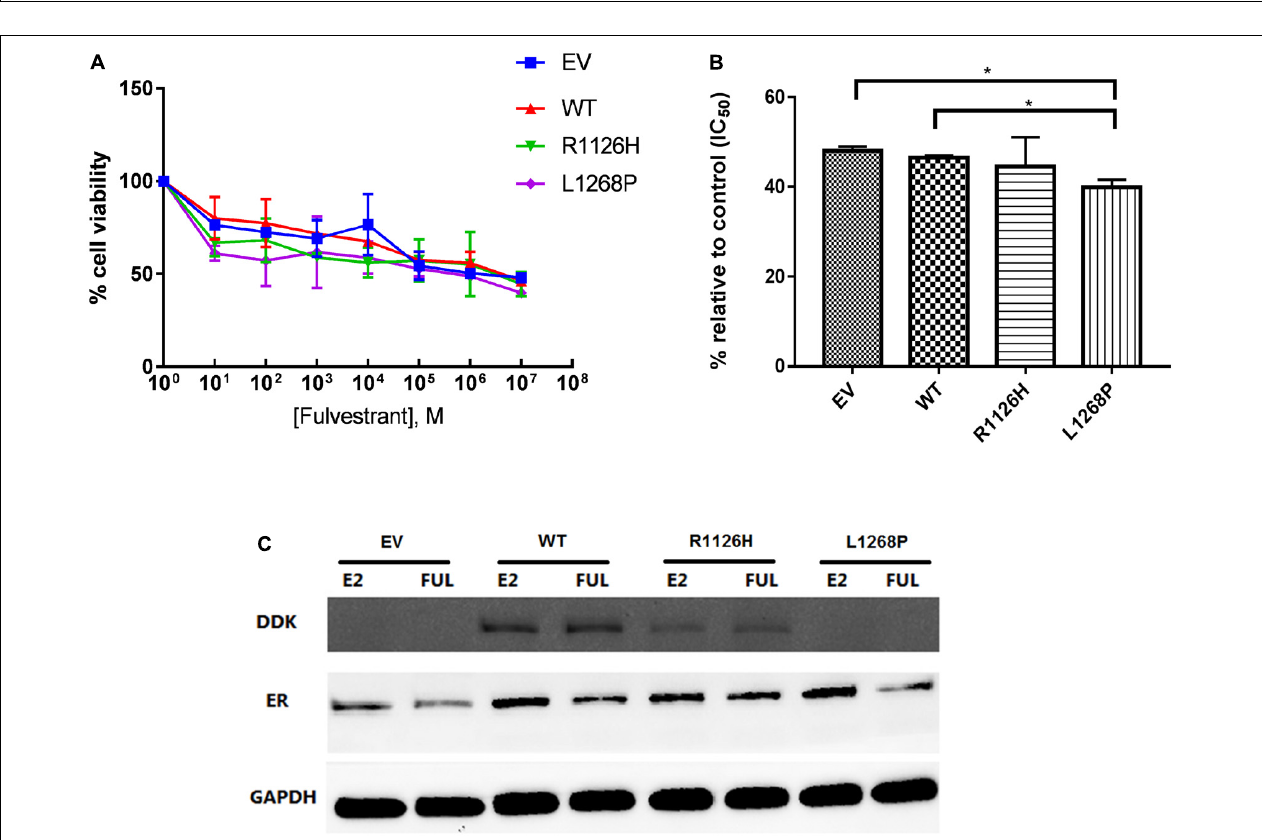
FIGURE 6 | Effect of Fulvestrant on cell proliferation in mutants WHSC1 expressing EEC1 cells. (A) Treatment was performed with 10 nM E2 and various dosage of Fulvestrant for 24 h. (B) Quantification of proliferation after exposure to 10 nM E2 and 10 − 3 M Fulvestrant. The values represent the percentage of growing cells compared to the normalized control (100%). Results represent mean values ± SD, n = 2 performed in triplicate. WHSC1 mutants counteract the effect of ER inhibitor. (C) EEC-1 cells were transiently transfected with WT, R1126H, and L1268P mutant constructs and treated with 10 nM E2 or 100 nM of Fulvestrant for 24 h. Protein lysates were prepared and analyzed by Western Blot with indicated